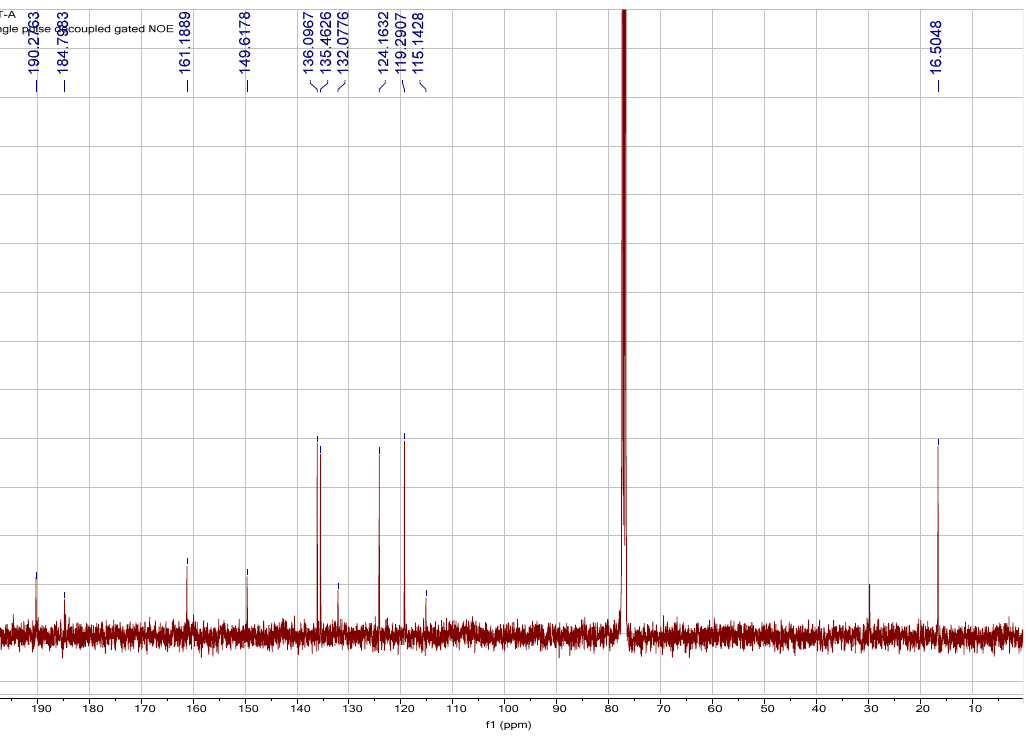
Fig. 2. Spectrum data of 13 C of the major compound isolated from EANT.